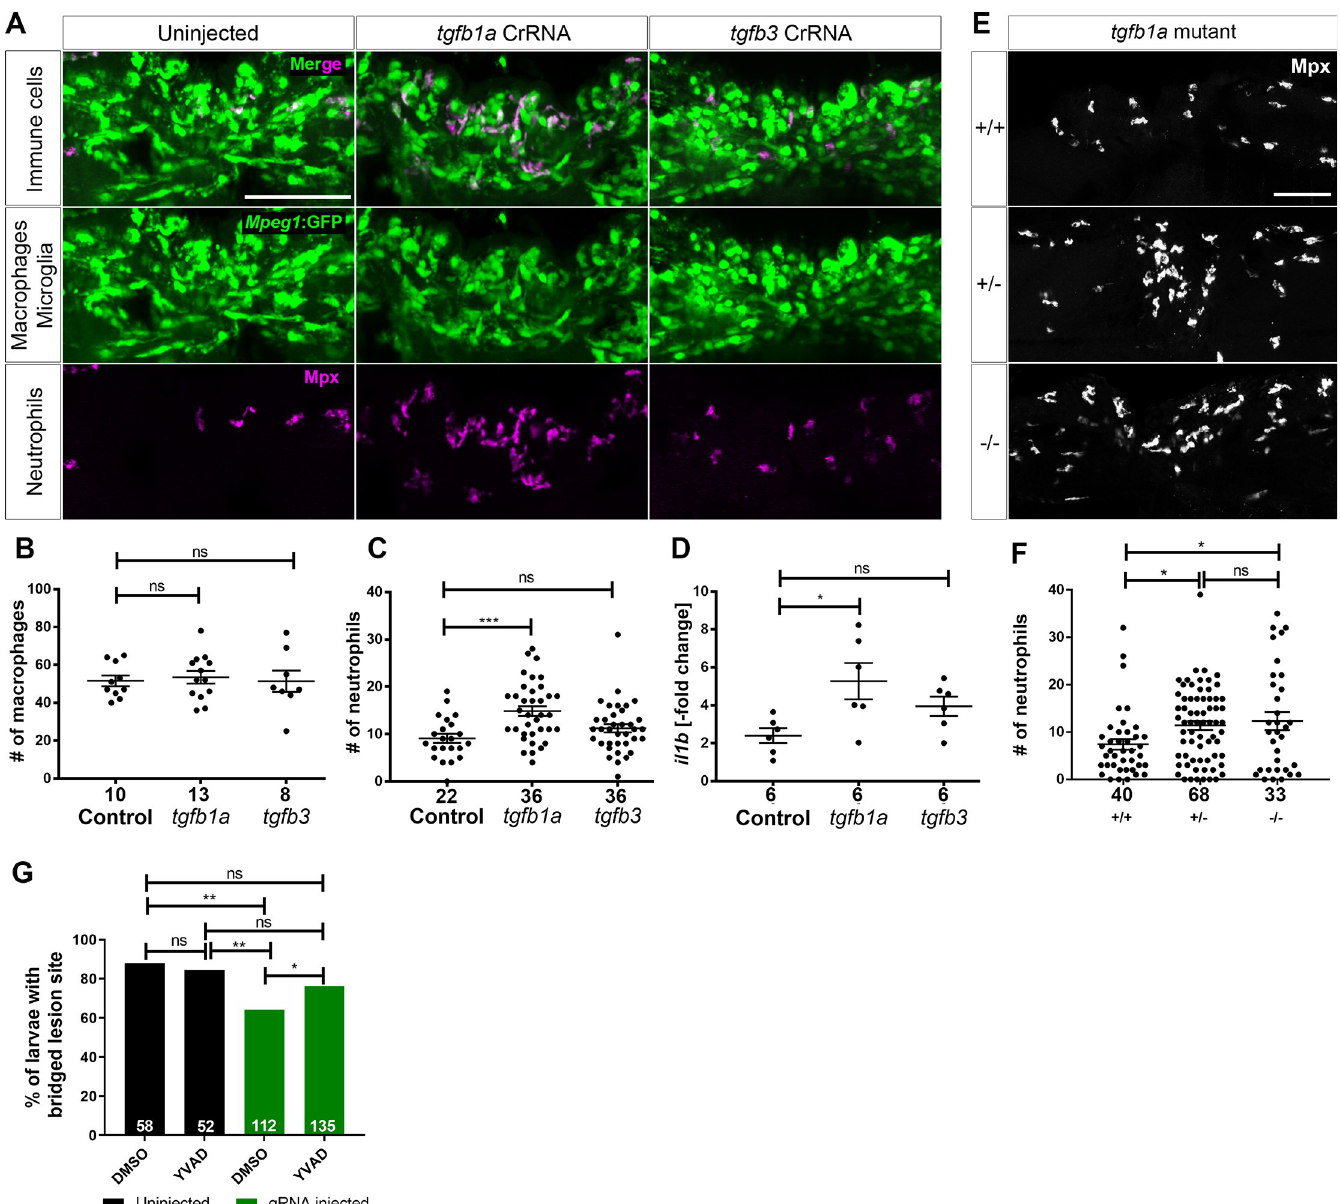
Fig 3. Loss of tgfb1a leads to prolonged inflammation. A: Lateral views of lesion sites in larval zebrafish are shown with the indicated markers and experimental conditions at 48 hpl. B-C: Quantifications show that numbers of macrophages were not altered by injecting any of the indicated haCRs (B; one-way ANOVA with Bonferroni’s multiple comparison test; Theoretical power = 0.85 to see a similar increase as for neutrophils in C), neutrophils were increased in number in tgf1b haCRs injected animals (one-way ANOVA with Bonferroni’s multiple comparison test, P = 0.0006), but not in tgfb3 haCRs injected animals (p = 0.32). D: Animals injected with tgfb1a haCRs, but not those injected with tgfb3 haCRs (P = 0.36), displayed marked increases in il1b expression levels in the lesion site compared to lesioned controls at 48 hpl (one-way ANOVA with Bonferroni’s multiple comparison test, P = 0.0211). All transcript levels were normalized to uninjected, unlesioned controls. E-F: tgfb1a heterozygous (one-way ANOVA with Tukey’s multiple comparison test, P = 0.0497) and homozygous mutant animals (P = 0.039) show increased numbers of neutrophils, comparable to haCR-injected animals. G: Inhibition of Il-1 β with YVAD rescued axonal bridging compared to the DMSO-treated control group in animals injected with tgfb1a haCRs (Fisher’s exact test � p < 0.05, �� p < 0.01). Numbers in B, C, F indicate numbers of animals; in D numbers of independent experiments. Error bars represent standard error of the mean (SEM). Scale bars = 50 μ m.